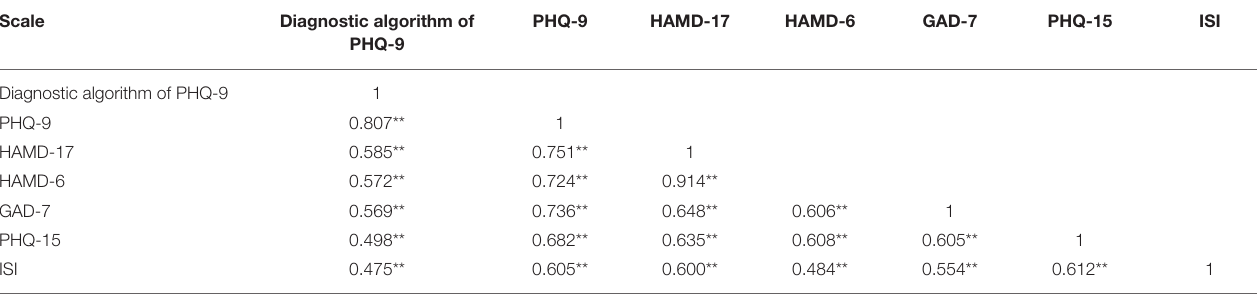
TABLE 2 | Pearson’s correlation